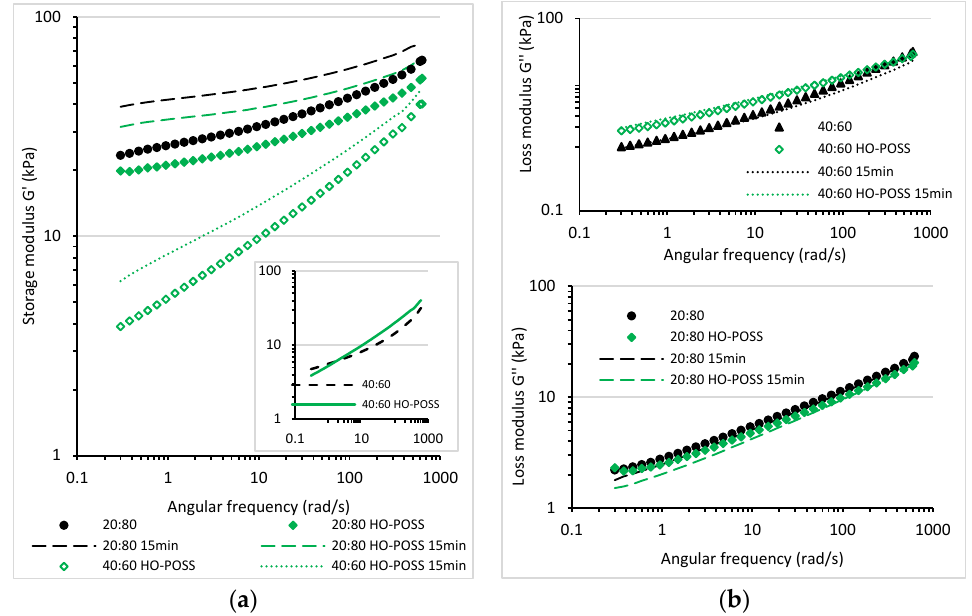
Figure 5. Influence of compression molding during 15 min at 160 °C on the viscoelastic properties of molten PLA/ENR/HO-POSS formulations. Storage shear G’ modulus ( a ); loss shear G” modulus ( b ).